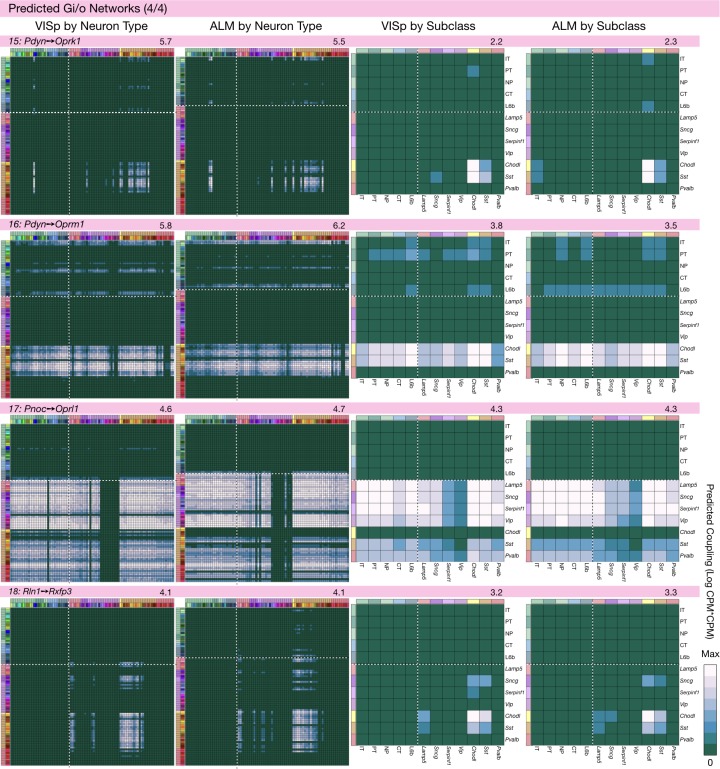
Neurotaxonomic coupling predictions for cognate NPP/NP-GPCR pairs #15-#18.Predictions for all 37 cognate pairs in both VISp and ALM cortical areas are grouped and color-coded according to Gα signal transduction family. All predictions were generated as described in connection with Figure 6 and represented as in Figure 6C–E for neuron types and in 6F for subclasses. Numbers at upper right indicate the maximum value to which each plot was normalized, in units of CPM*CPM.